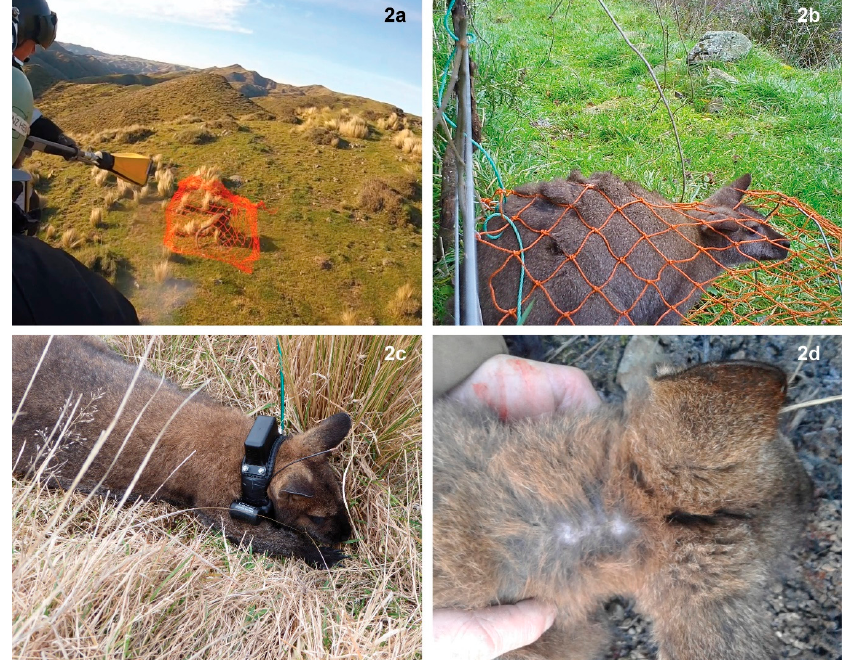
Figure 2. Methods used for capturing Bennett’s wallabies ( Notamacropus rufogriseus ) in South Canterbury, New Zealand, 2018–2019, included ( a ) helicopter-based net-gunning and ( b ) ground-based netting. The GPS-collars we used ( c ) were customised and weighed c. 200 g: we only collared adult wallabies ( ≥ 9 kg), and therefore the weight of the collars did not exceed about 2% of wallaby body weight, within the accepted international standard. The GPS-collars caused only minor rubbing ( d ) of the neck fur on collared individuals, even after they were worn for 1 to 2